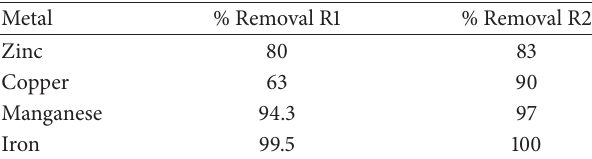
Table 1: Percentage removal of heavy